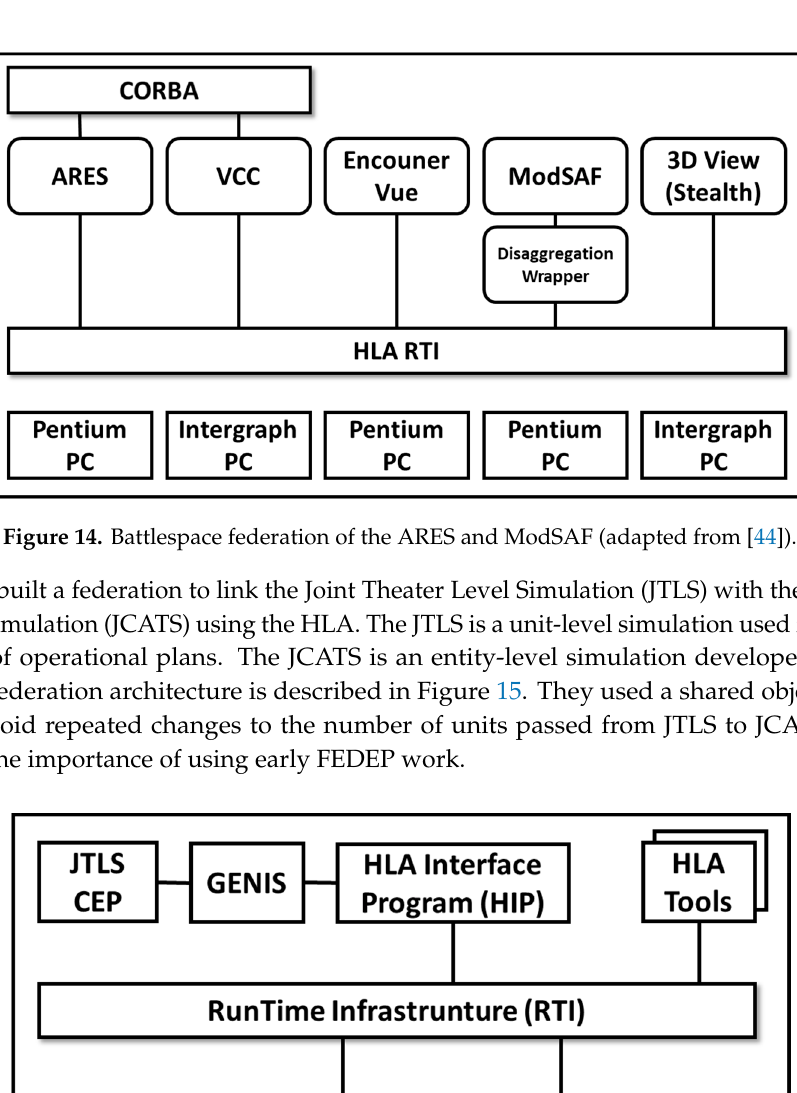
Figure 13. The federation of the TYR, FBSIM, and ARTEVA (adapted from [43]).